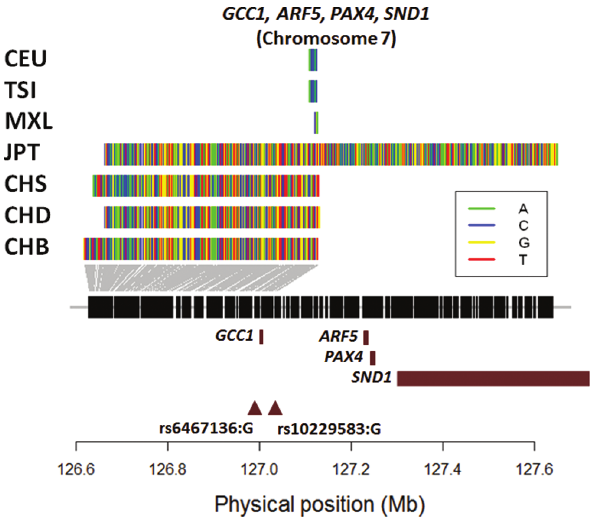
Figure 2. Long haplotypes around two T2D-associated SNPs in East Asian and European populations. Illustration of haplotype forms identified by haploPS that span the longest genetic distance around two SNPs rs6467136 and rs10229583 that are located around a cluster of four genes on chromosome 7 (brown horizontal bars: GCC1 , ARF5 , PAX4 , SND1 ). The figure shows the uncharacteristically long haplotypes that were present at a haplotype frequency of 40% in the four East Asian populations (CHB, CHD, CHS, JPT), together with the longest haplotypes present in the European populations (CEU, TSI, MXL) that were comparatively much shorter and did not yield significant evidence of positive selection. The haplotypes for the four East Asian populations carried both risk alleles at the two SNPs that have been reported in association studies to increase the risk to Type 2 diabetes.